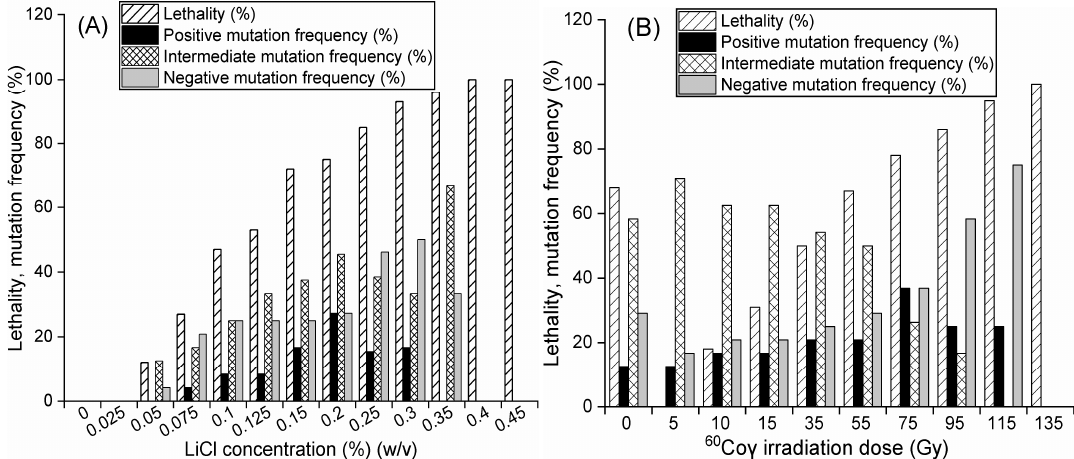
frequency in LiCl and LiCl+ 60 Co γ mutagenesis. ( A ) LiCl mutagenesis. ( B ) LiCl+ 60 Co γ compound